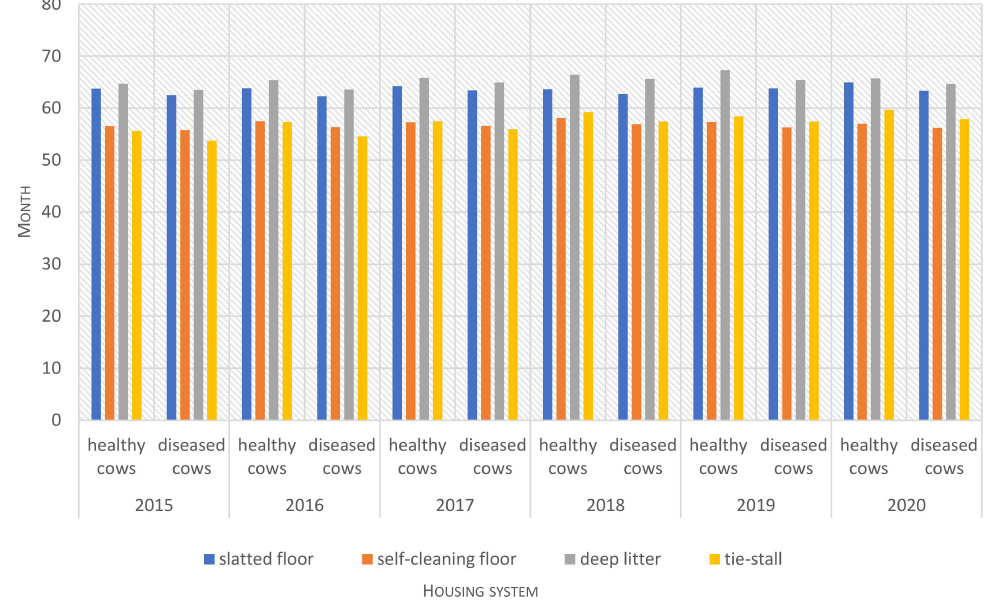
Figure 6. Productive lifespan (in months) of healthy and diseased cows kept in different housing systems in each year of the study (2015–2020). Foot diseases accompanied by lameness (mostly contusion, footrot and sole ulcers), retained placenta and pneumonia were most prevalent in the evaluated herds in each year (Figure 7) and during the entire period of the study (Table 3). Conjunctivitis, interdigital hyperplasia and laminitis were least frequently noted.